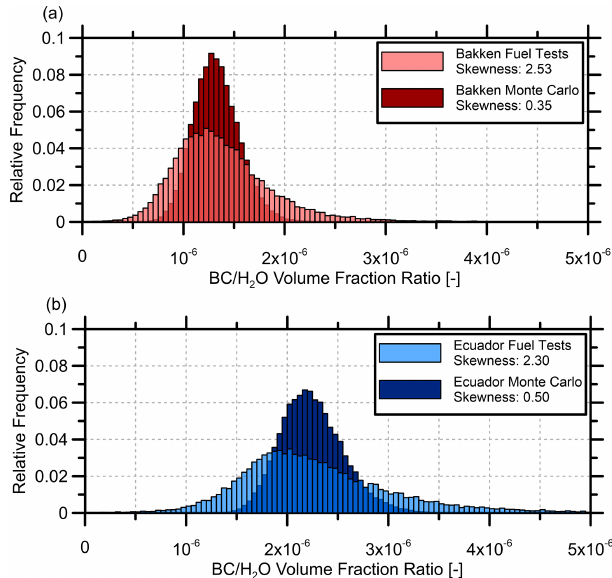
Figure A6. Distributions of black carbon (BC) / H 2 O volume frac- tion ratios from Monte Carlo simulations with error related to beam steering, system noise, and spatial- and